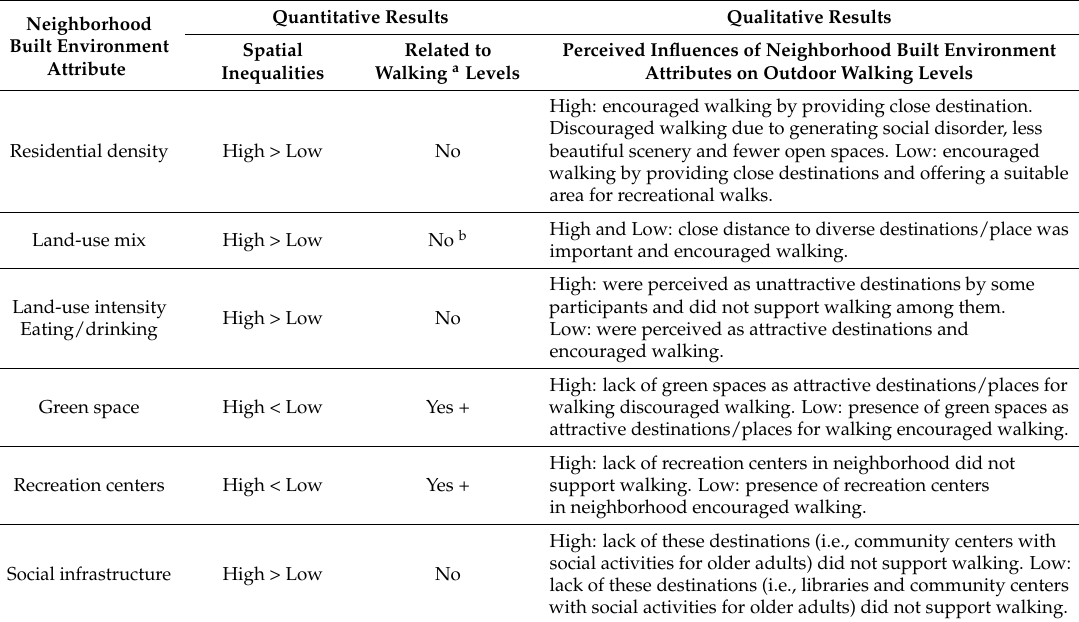
Table 8. Combination of quantitative and qualitative